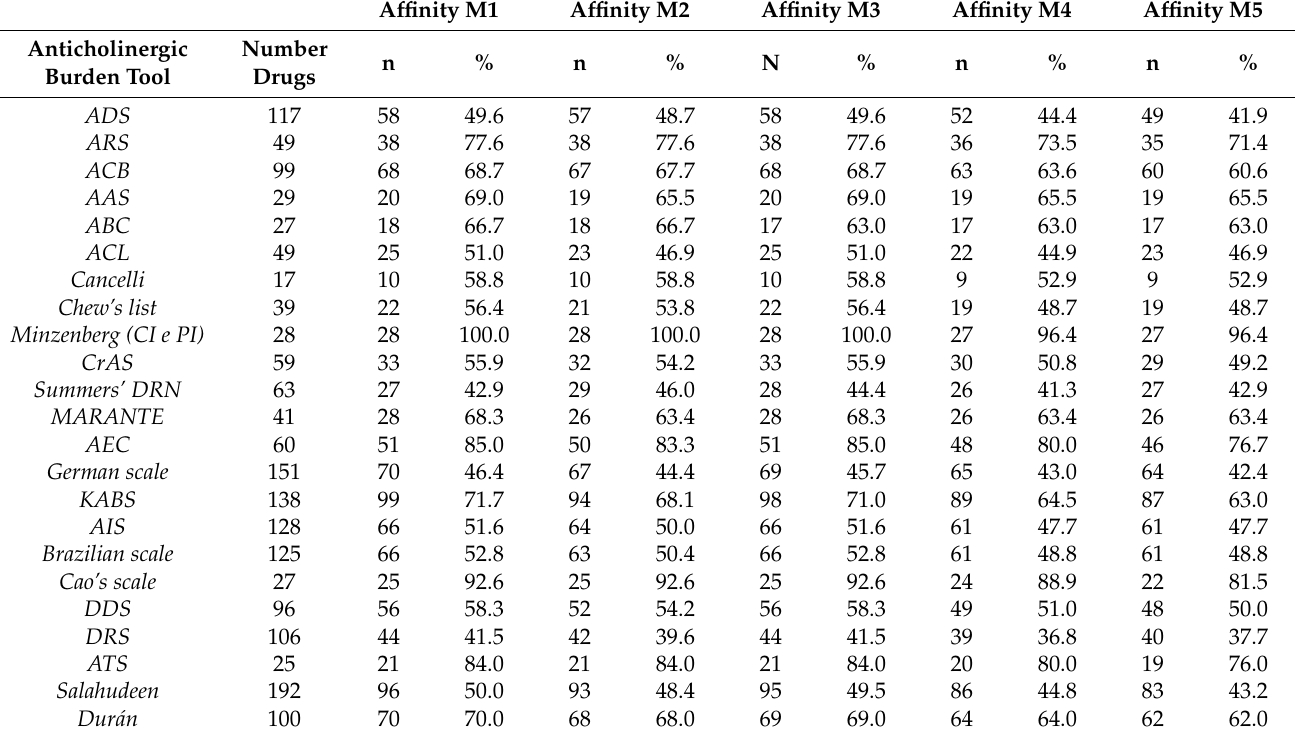
Table 3. Proportion of drugs with reported affinity for each of the muscarinic receptor subtypes as a function of the total number of drugs that each anticholinergic burden tool includes.